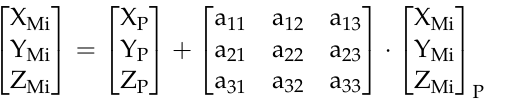
(with the positive X-axis towards the front of the car, the positive Y-axis towards the left,